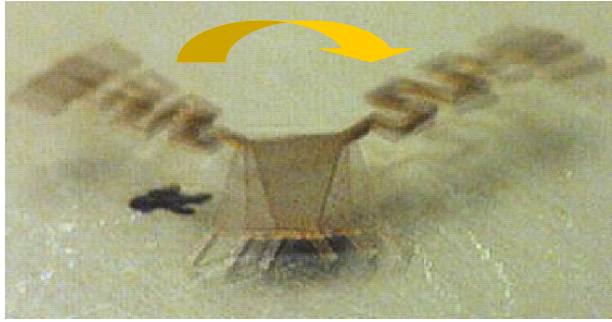
Figure 6. Still shots illustrating the robot turning clockwise at 810 Hz.